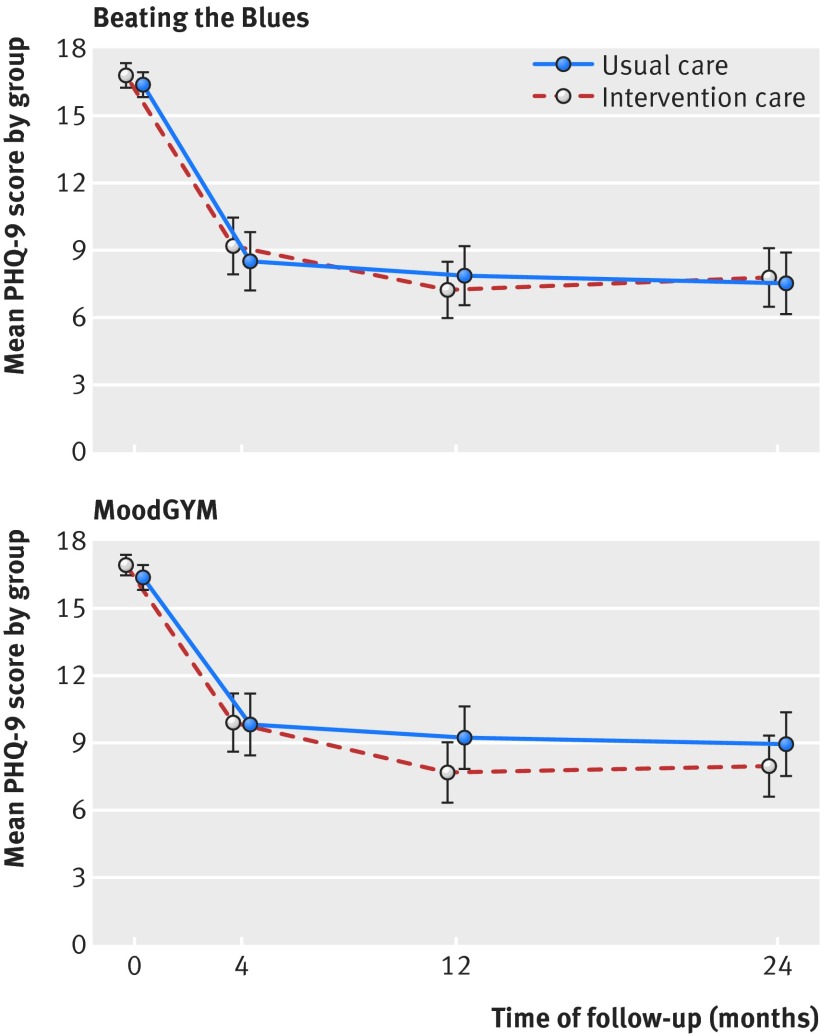
Fig 2 Depression status measured with PHQ-9 across all follow-up points. Means are all predicted means and 95% confidence intervals estimated from mixed model with sex, age, baseline PHQ-9 score, duration of depression, level of anxiety, month, treatment, and interaction between month and treatment as fixed effects